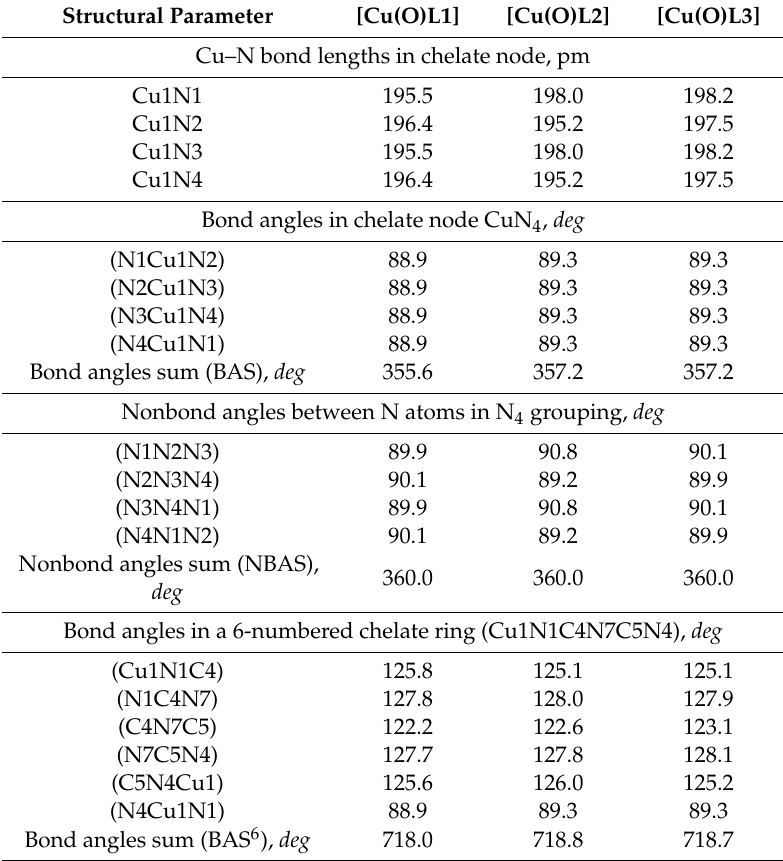
Figure 3. Images of highest occupied (HOMO) and lowest unoccupied (LUMO) molecular orbitals in the [Cu(O) L1 ] (ground state–spin doublet, M S = 2) [Cu(O) L2 ] and [Cu(O )L3 ] complexes (ground state–spin quartet, M S = 4). The values of energies of these molecular orbitals (in brackets) are given in eV. The symbol “alpha” corresponds to electron with spin (+1/2), “beta”, to electron with spin (–l/2). Table 1. Key bond lengths and bond angles in the [Cu(O) L1 ], [Cu(O) L2 ] and [Cu(O) L3 ] complexes. Structural Parameter